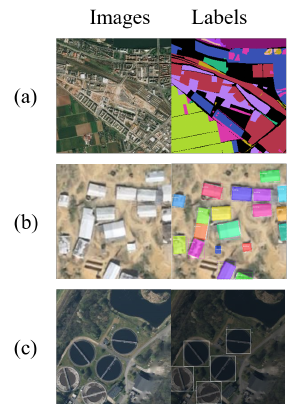
Figure 3. Examples of OSM training data generated by ohsome2label. (a) LULC classification; (b) semantic segmentation of human settlements; (c) object detection of wastewater treatment plants. Figure 4. The overview map of study areas as a proof of concept. (1) the Tanzania training area for the base model (well-mapped in OSM); (2) the target area Mozambique split by 80% for fine-tuning and 20% for test (completely missing in